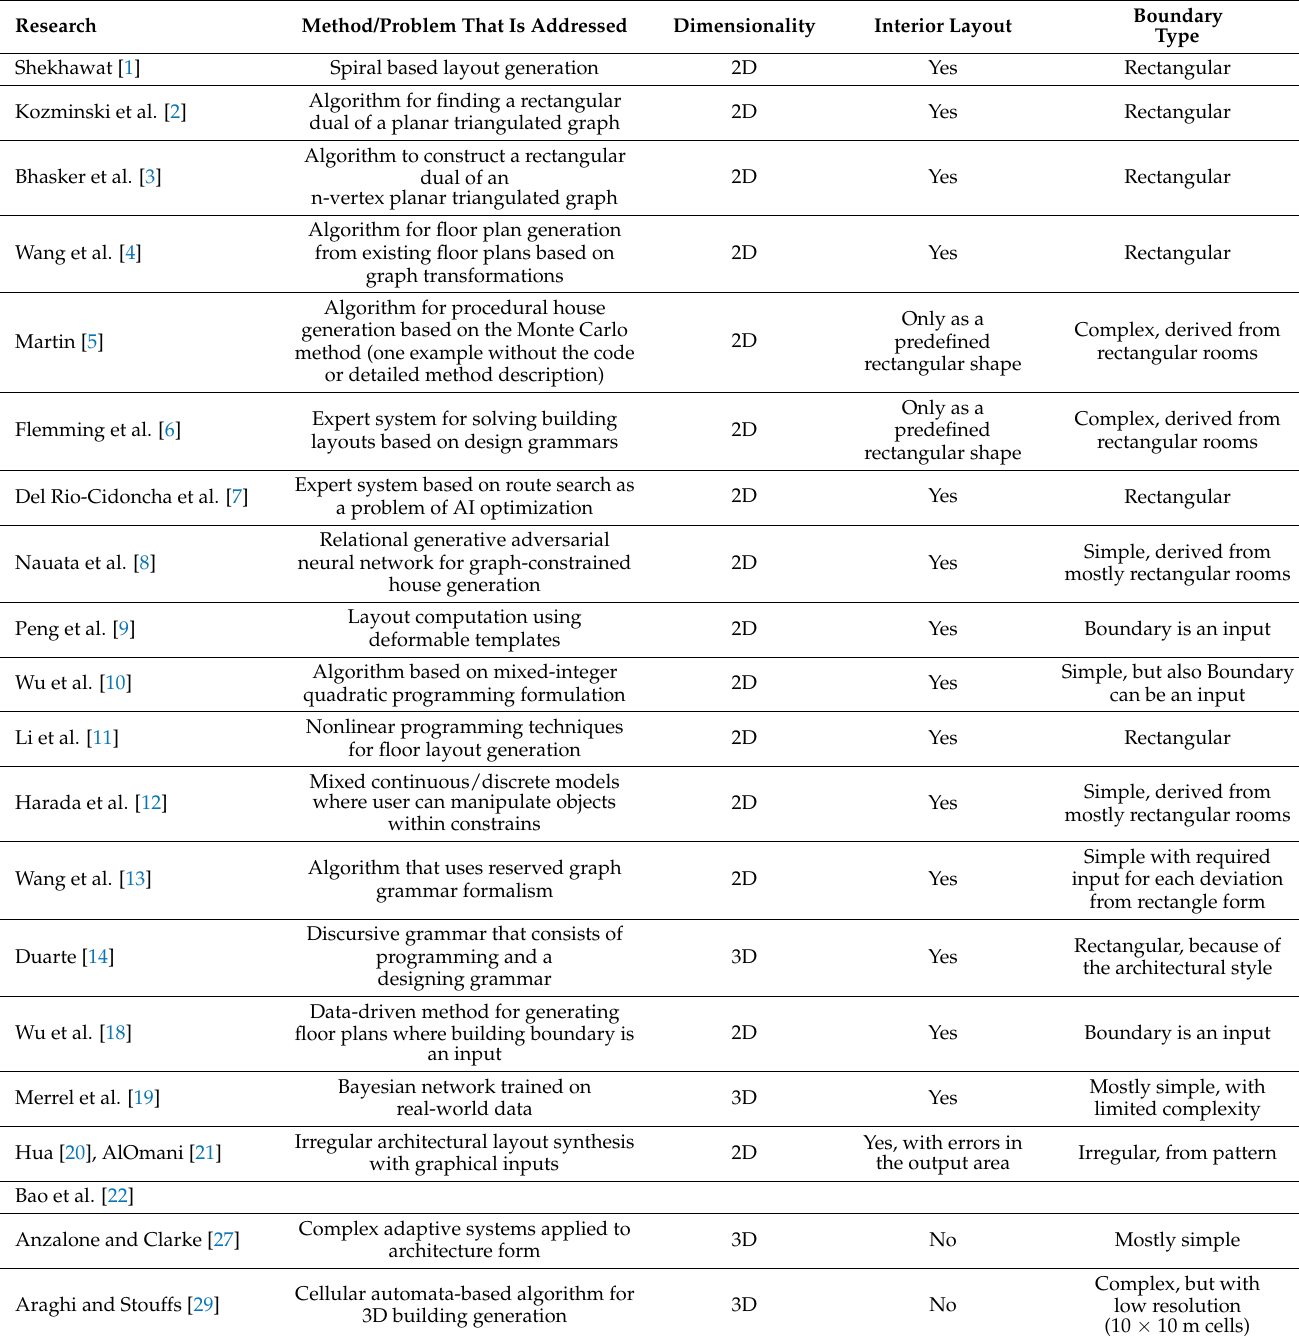
Table 1. The comparative analysis of related work relevant to this article.